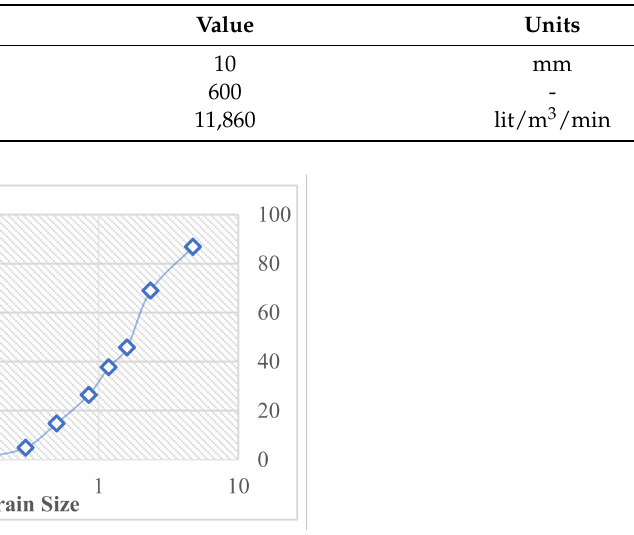
Table 4. Specifications of coir geotextile used in the experiments.